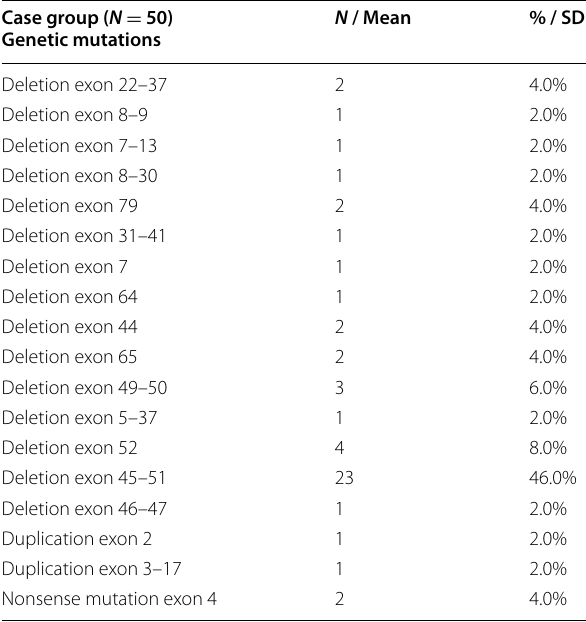
Table 5 Types of dystrophin gene mutations identified in the case group